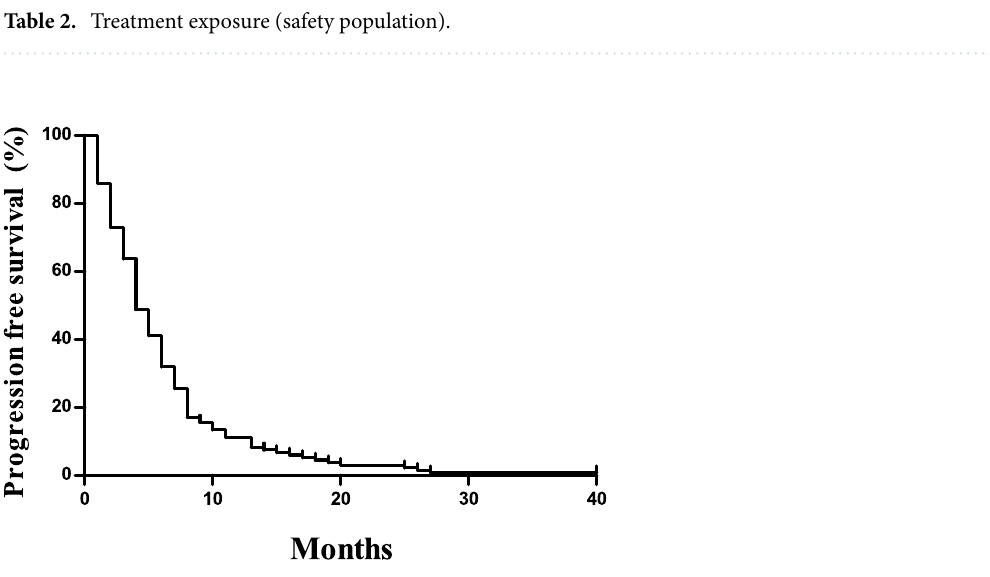
Figure 1. Progression free survival of the study cohort.